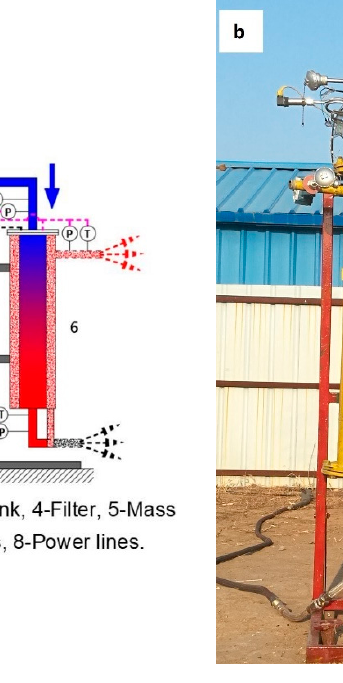
Figure 4. ( a ) Schematic diagram and ( b ) photograph of experimental system.